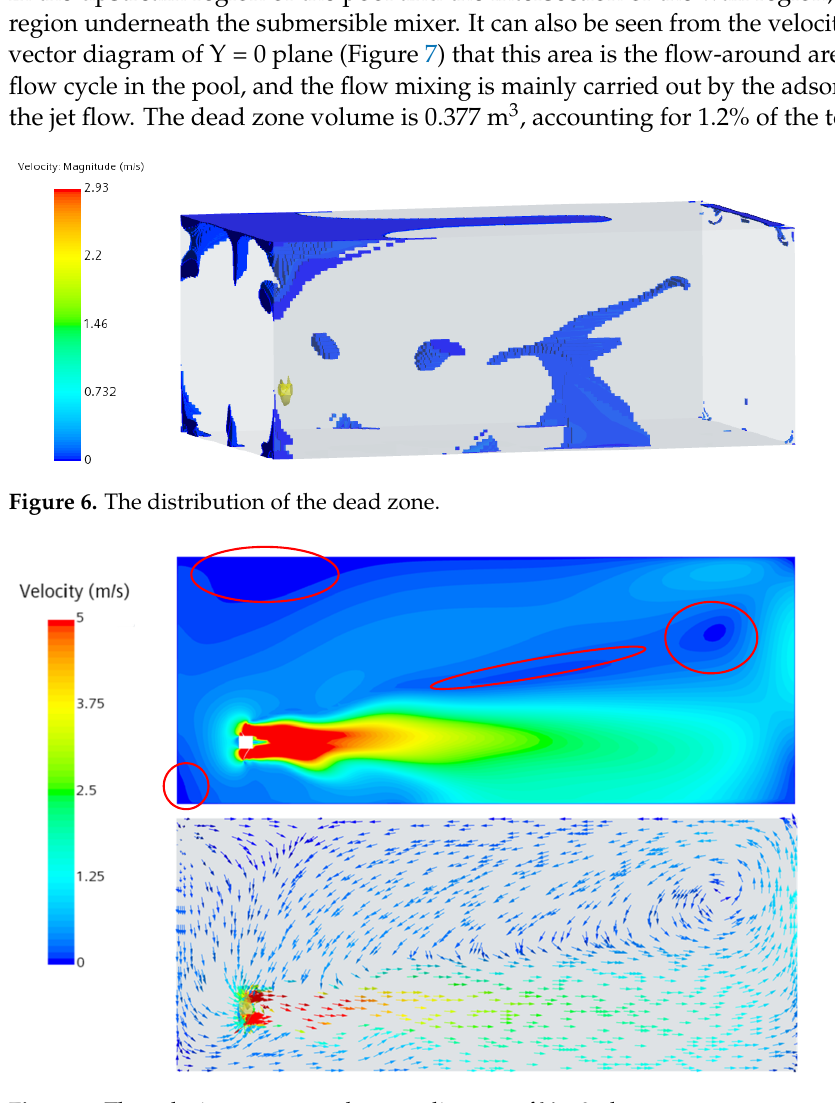
Figure 7. The velocity contour and vector diagram of Y = 0 plane.